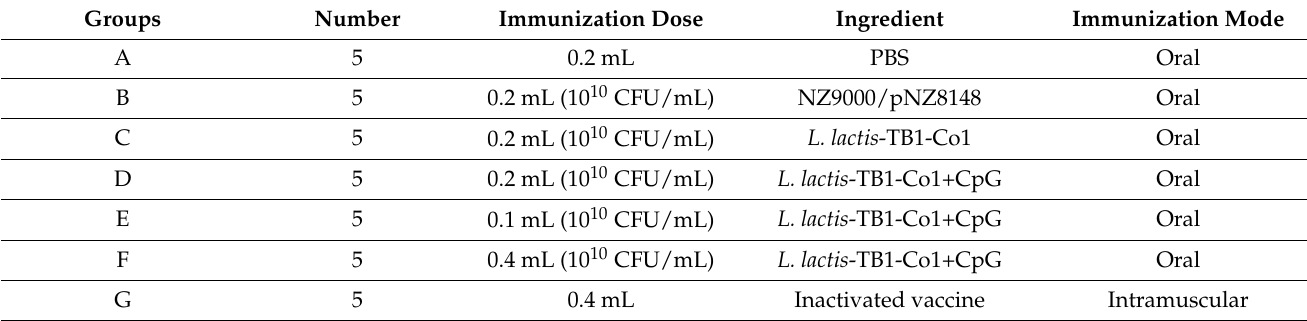
Table 5. Immunization schedule in guinea pig